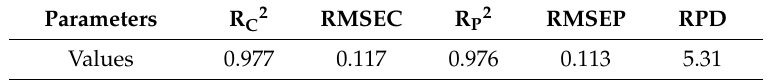
Table 2. R 2 Regression Coefficients, RMSEC, RMSEP, RPD for Calibration and Prediction Curve.